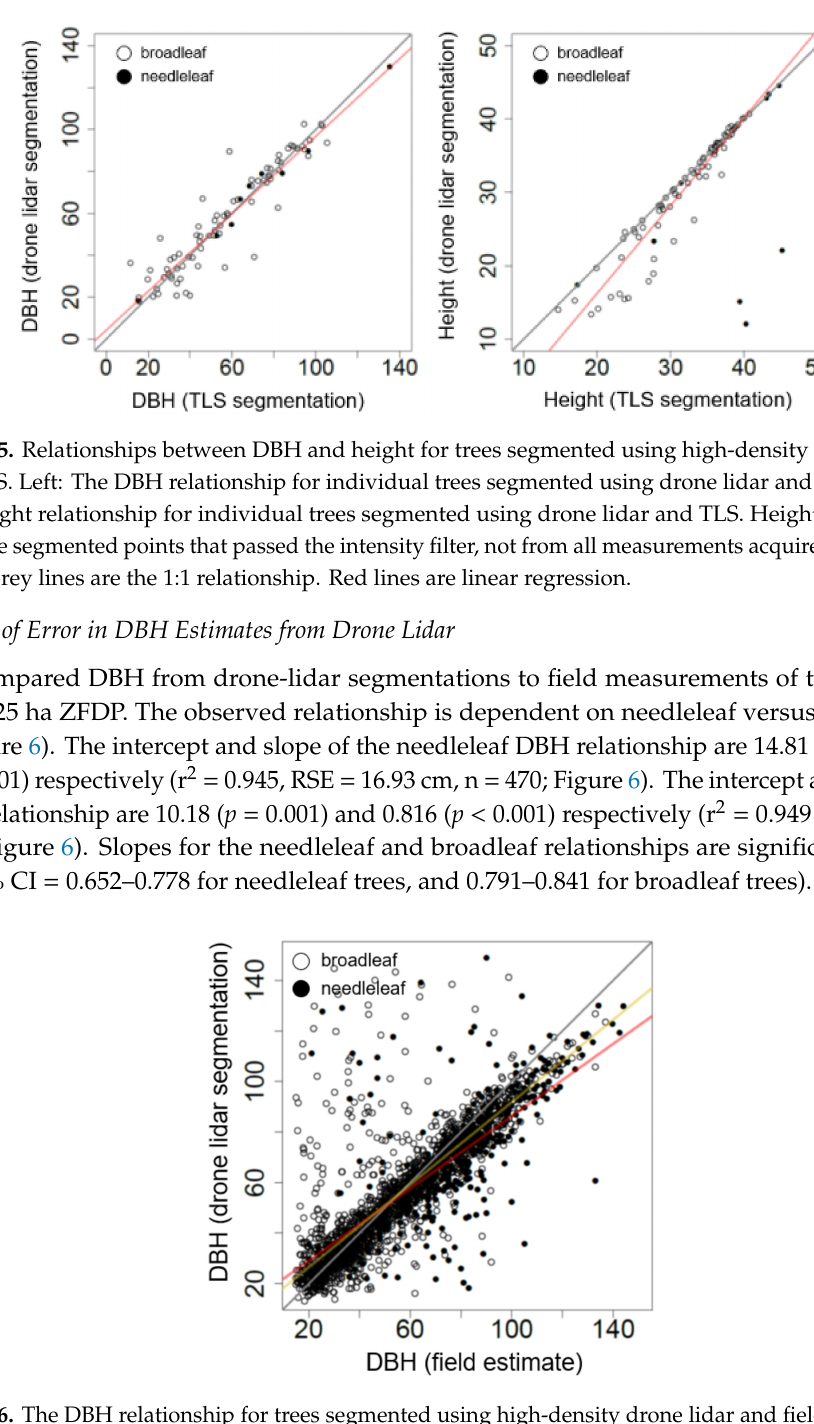
Figure 6. The DBH relationship for trees segmented using high-density drone lidar and field estimates. Grey line is the 1:1 relationship. Red line is the needleleaf-tree regression. Orange line is the broadleaf-tree